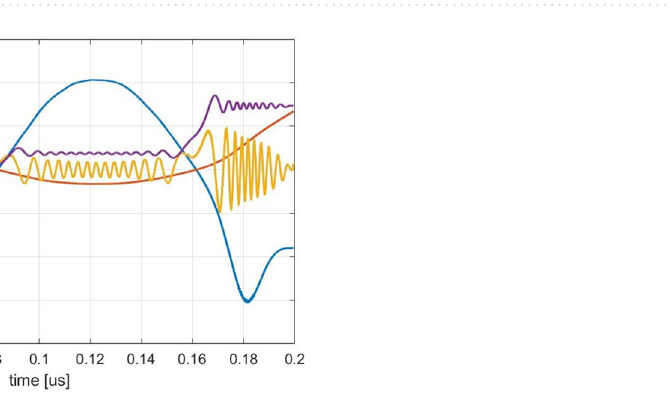
Figure 14. trajectory parameters of an electron that cross two times the ECR